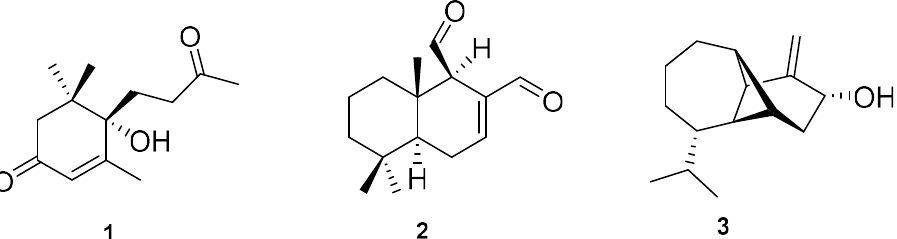
Figure 1. Examples for cytotoxic sesquiterpenoids: dehydrovomifol ( 1 ), polygodial ( 2 ), and lemnalol ( 3 ) [12].